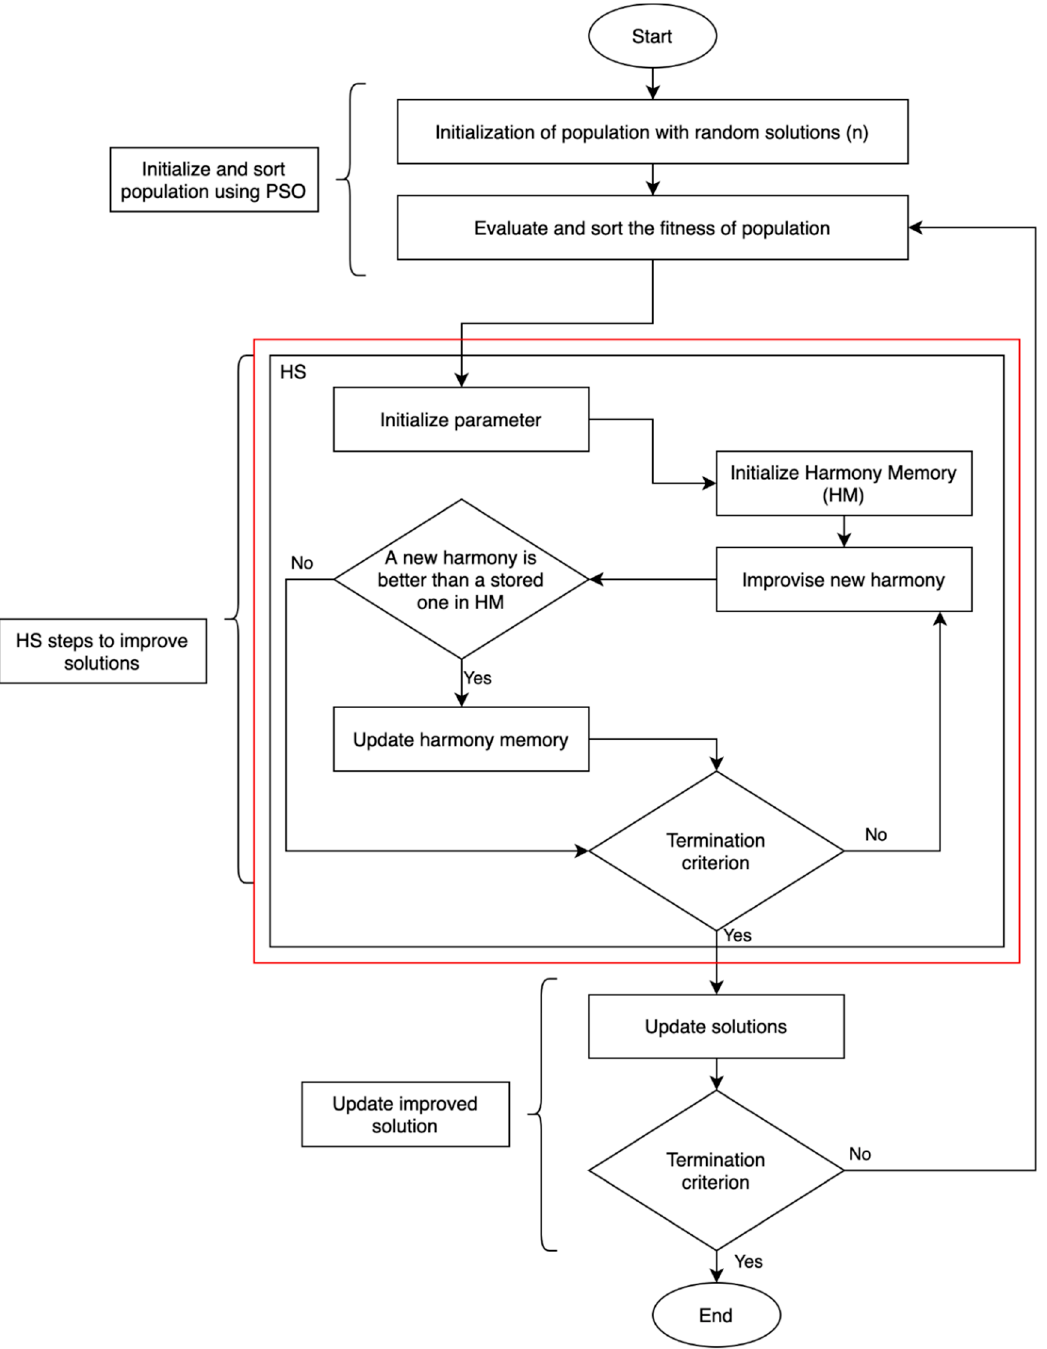
Figure 3. Steps in PSOHS for estimating parameter value. The red box is Harmony Search, which is hybridized with PSO to improve its performance.